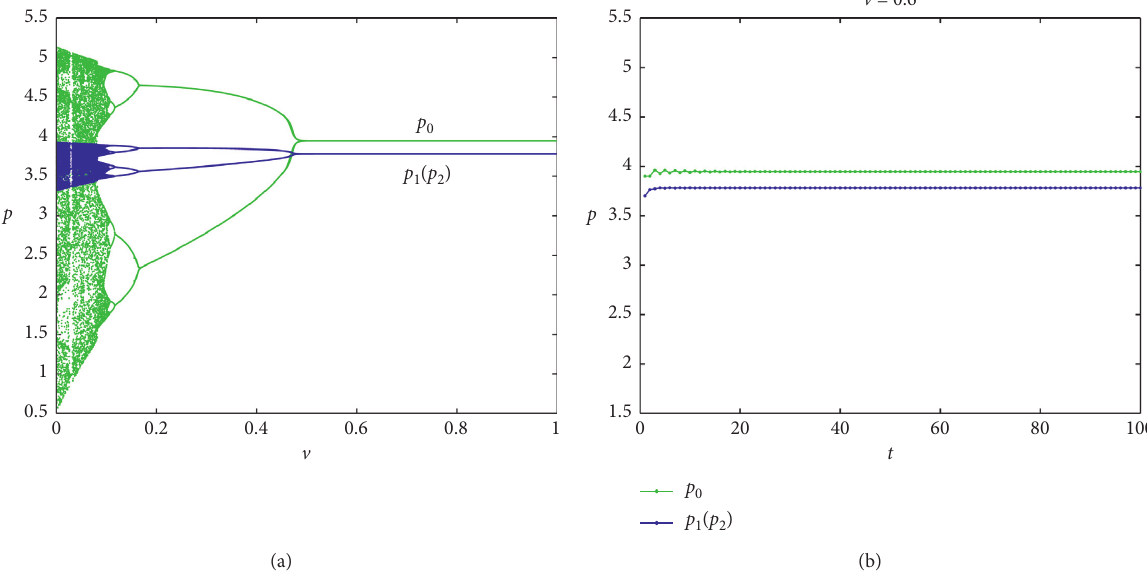
Figure 13: (a) Bifurcation diagram for system (47) with control parameter ] . (b) Revolution trajectories for system (47) when ] � 0 .